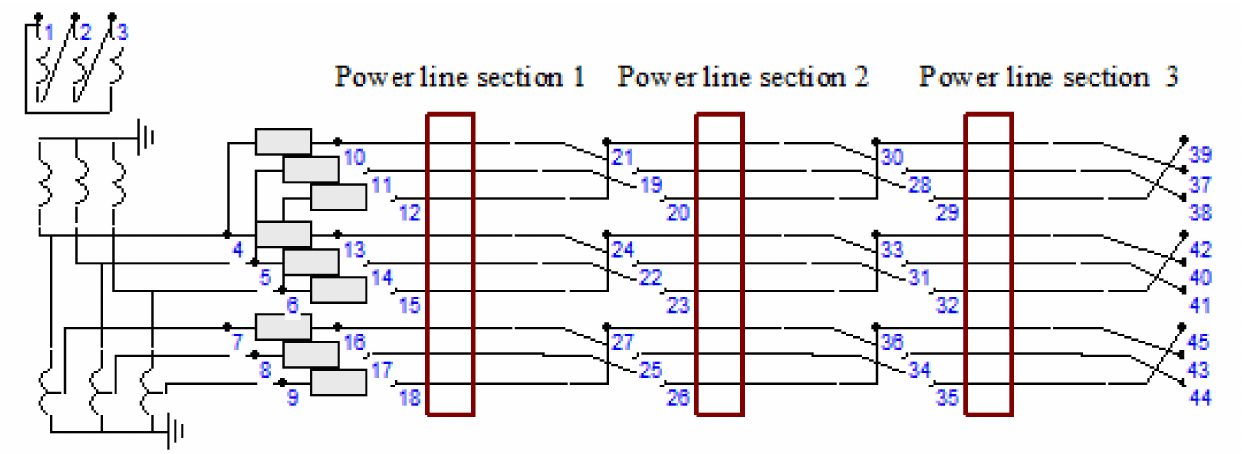
Figure 12. Equivalent circuit used by the Fazonord software package with transmission line